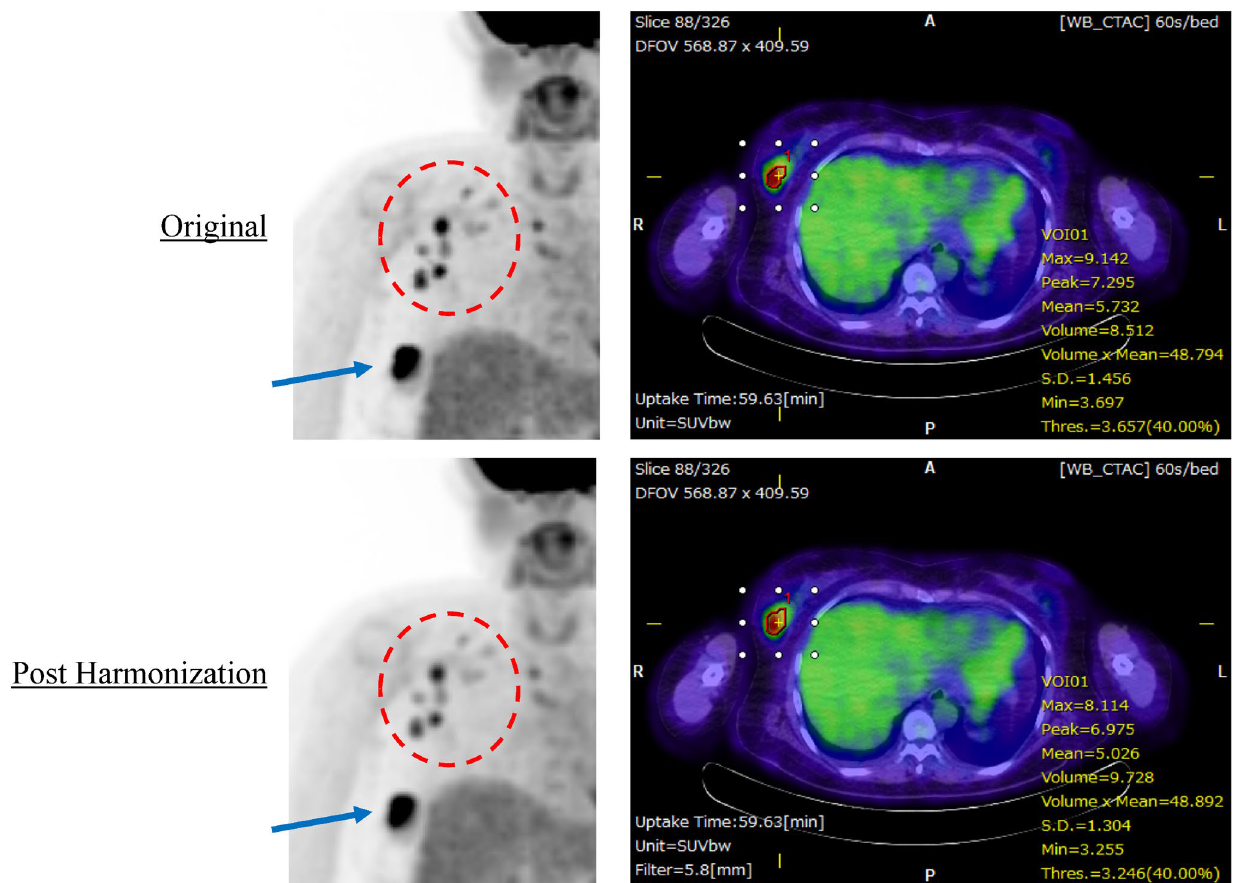
Figure 8. A case with accumulation of FDG in the right primary breast cancer and metastatic lymph nodes. Maximum intensity projection images (left column) and fused PET/CT images (right column) before and after harmonization are shown. The fused images show quantitative values calculated by applying a threshold of 40% to VOI using RAVAT for right primary breast cancer